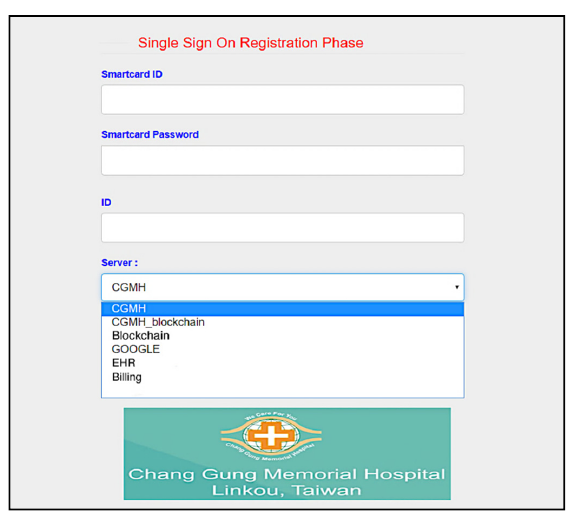
Figure 11. Server query.